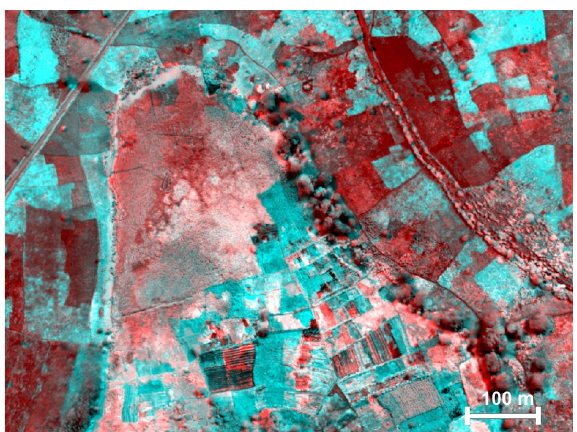
Figure 3. Ortho-photo of the Malinda Wetland, derived out of 2400 images taken with the UAS SUSI 62, August 2012 The boundary of the frequently flooded part of the wetland could be delineated quite well by the different colour of the soils: the humous soils in the centre are black, the soils where not much organic matter is deposed by the flood are reddish, due to the laterite content. The use of a principal component image computed out of the layer-stacked images was helpful in this context, as explained later on.